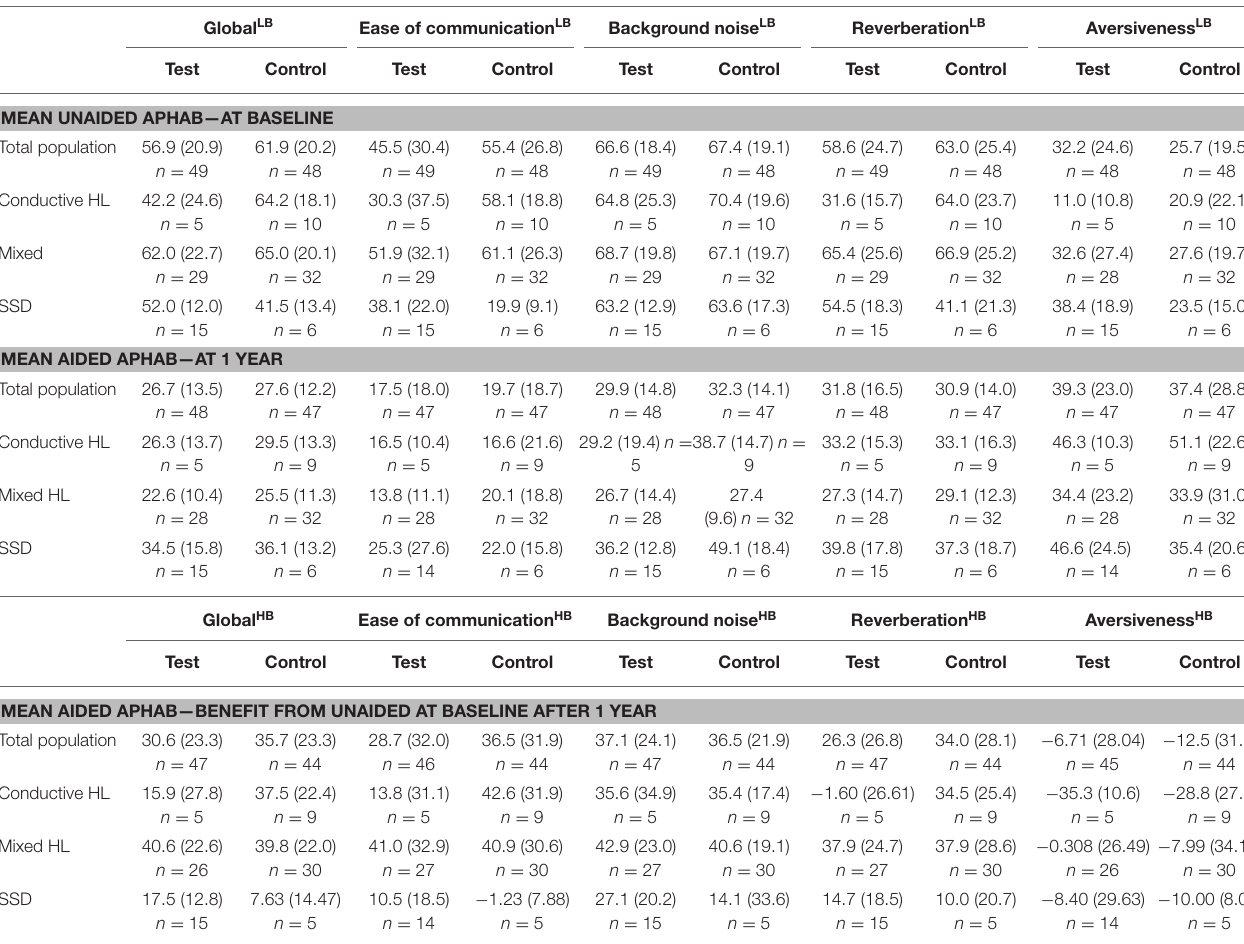
TABLE 6A | Abbreviated profile of hearing aid benefit over the first